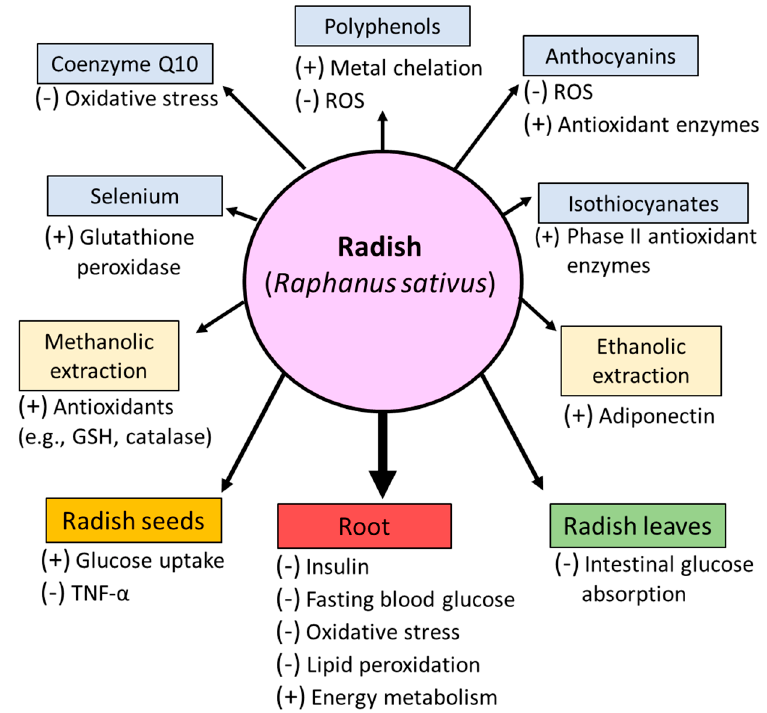
Figure 1. Effect of radish and some of its bioactive components on type 2 diabetic conditions. (+) increase; ( − ) decrease; ROS: reactive oxygen species.